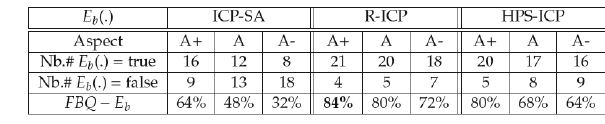
Table 2. Qualitative evaluation of the registration results in